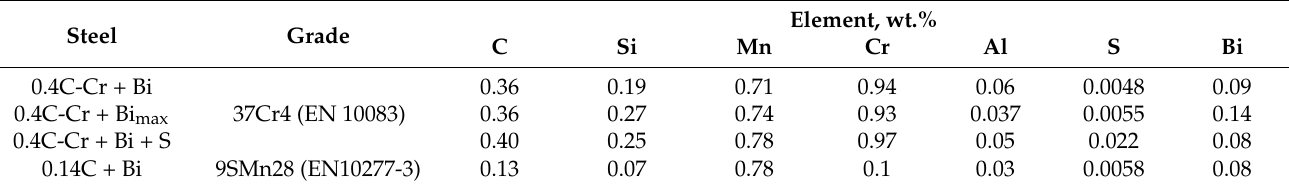
Table 1. The chemical composition of experimental